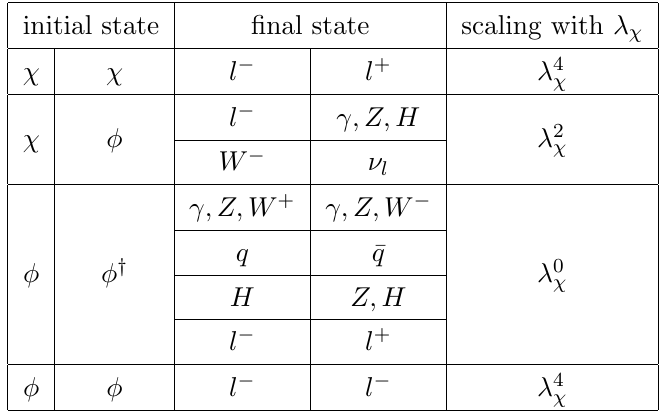
Table 1 . List of all relevant (co-)annihilation processes. The leptons involved are denoted by l = e; (cid:22); (cid:28) . Also the dependence of the cross section on the coupling constant (cid:21) (cid:31) is denoted in the last column. The (cid:30)(cid:30) y annihilation into l (cid:22) l also has contributions scaling with (cid:21) 2